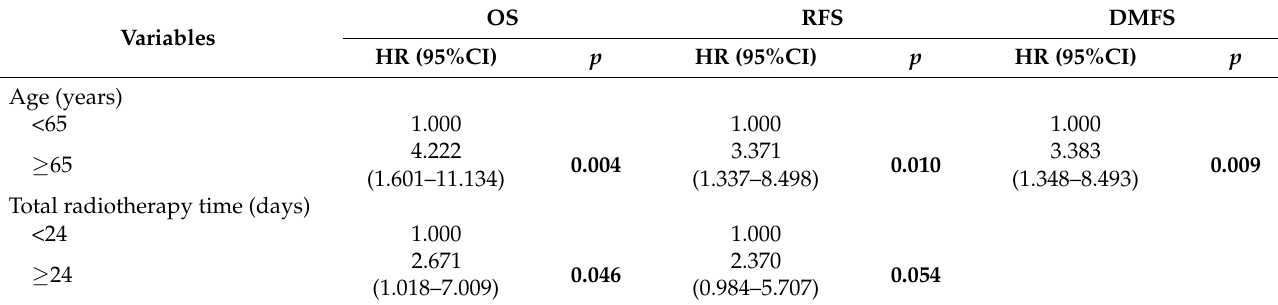
Table 3. Multivariable Cox analysis of OS, RFS, and DMFS after PSM.